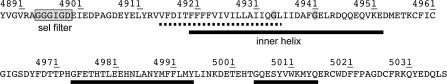
Secondary Structure PredictionPredicted regions of hydropathy (dashed line) and α helix (continuous line) for the C-terminal region of RyR1. The position of the selectivity (sel) filter is also indicated. The Gly residues (highlighted in gray) are possible points of flexibility.